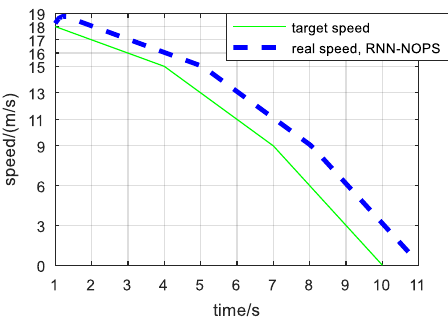
Figure 3. Speed of the EV during the braking process under control of RNN-NOPS. Take 2 representative constraints, c 5 ( x ) and c 6 ( x ) as examples, their 59 training trajectories (representing 59 training sample times considering c 5 ( x ) and c 6 ( x ) ) at first 5 × 10 4 iterations of RNN-NOPS and EPNN are shown in Figure 4. It is seen that c 5 ( x ) is often positive at initial iterations, representing φ r exceeds φ f . Since the braking ratio is fixed at every step, according to Equation (20), increasing φ f is the feasible way to recover the violated c 5 ( x ) , which means c 6 ( x ) must be increased. From Figure 4b,d, it is seen that negative c 6 ( x ) is increased but within its feasible range, indicating that all the algorithms effectively find a way to recover violated constraints.